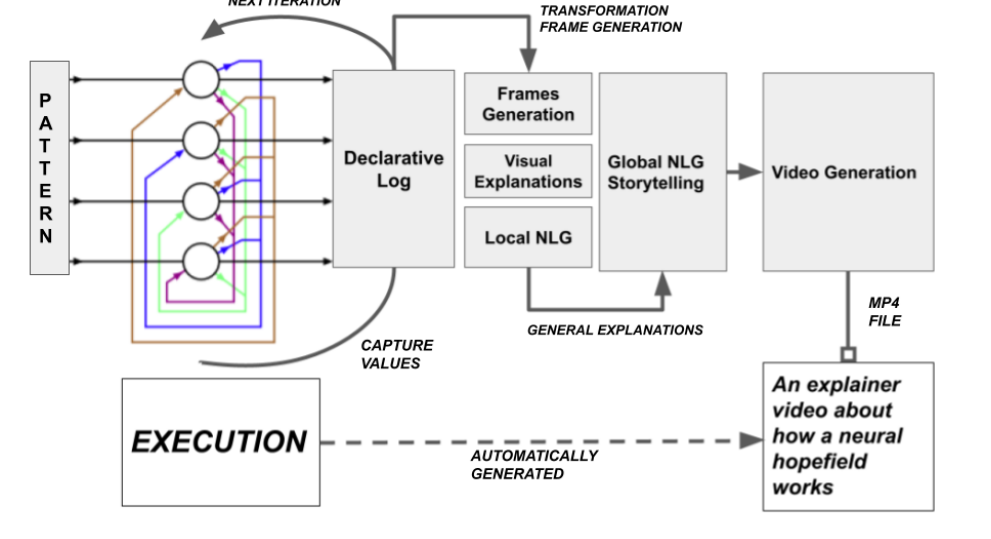
Figure 4. A general methodology for transforming HNN’s execution in an explainer video using four phases: trace, frames generation/local NLG, storytelling/global NLG and video